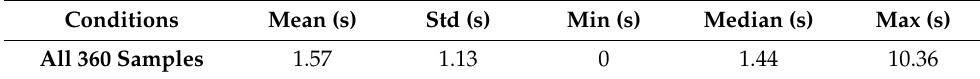
Table 6. Statistical summary of Min TTC in the critical scenarios.